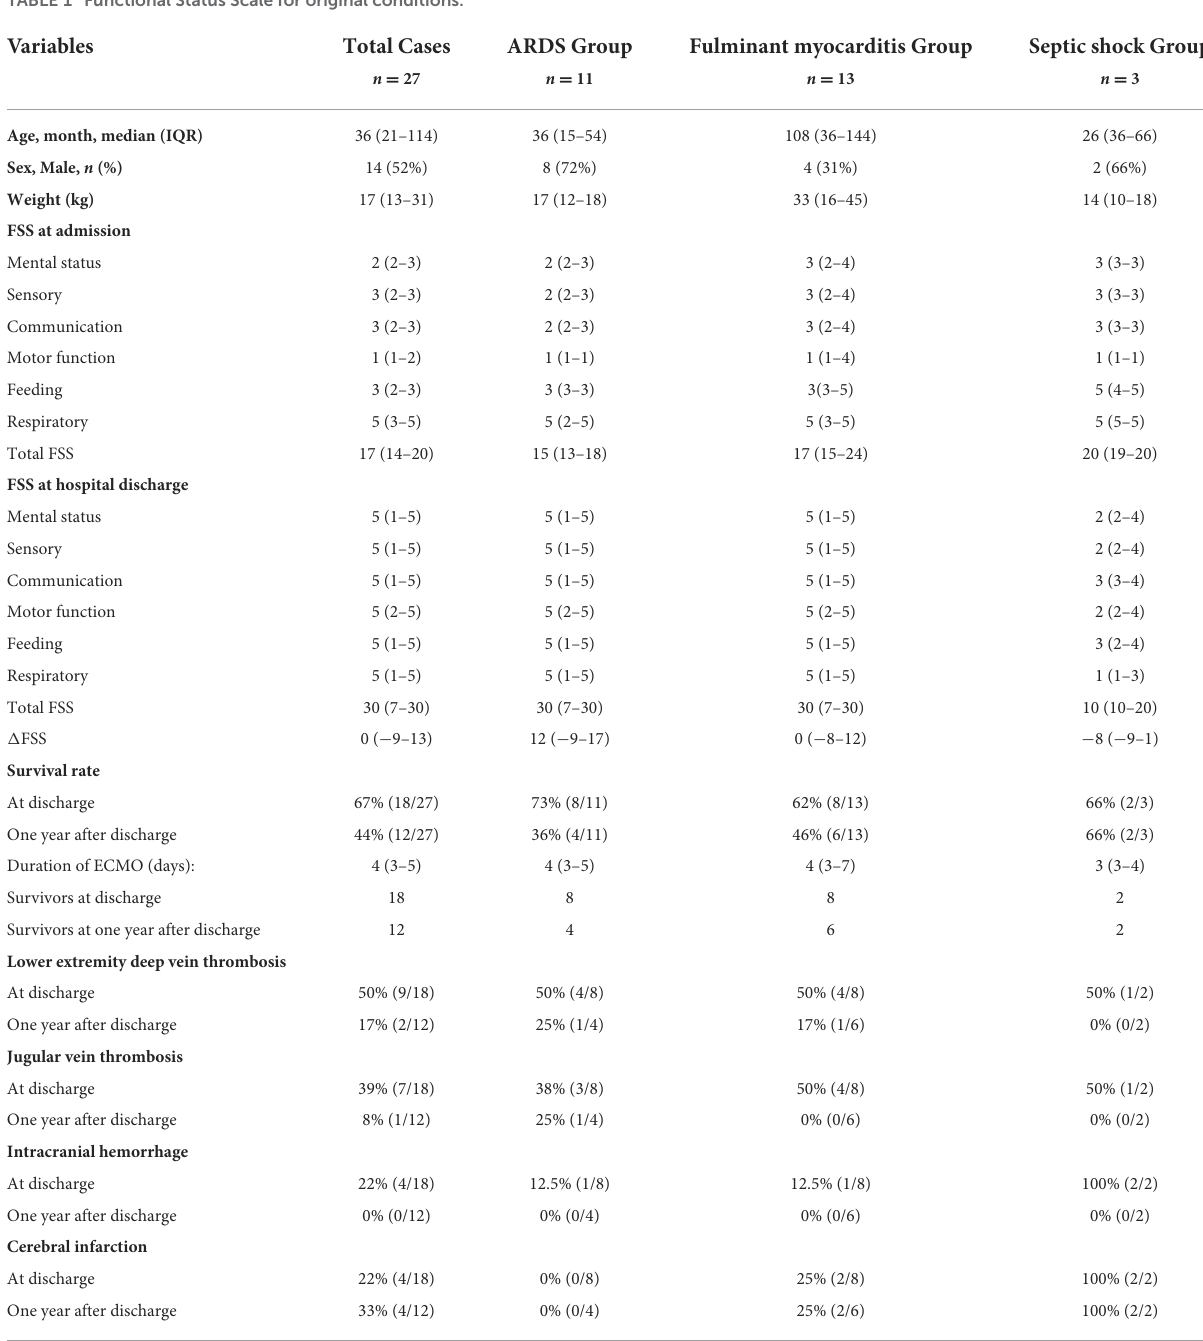
TABLE 1 Functional Status Scale for original